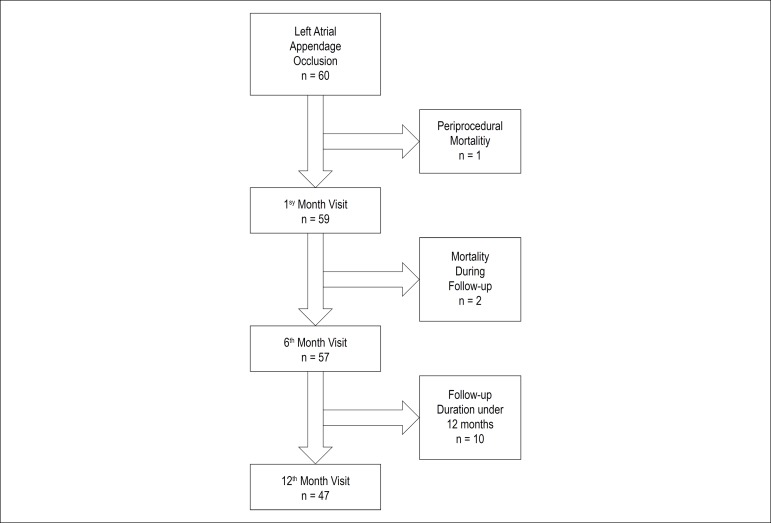
Patients’ follow-up.